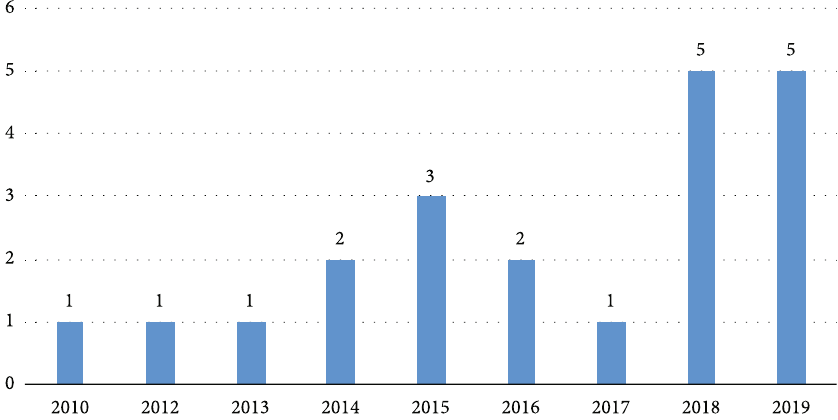
Figure 1: The PRISMA-based article selection process fl ow chart.